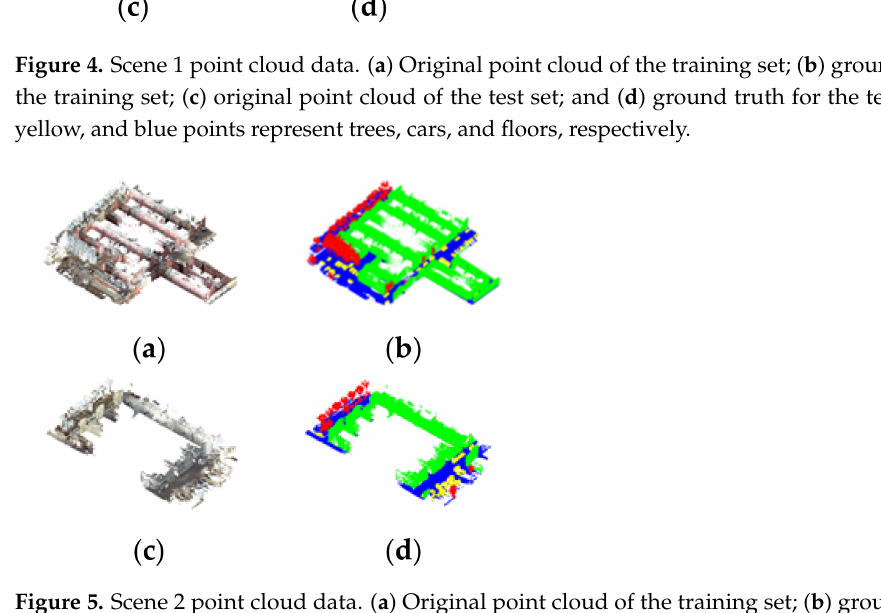
Figure 5. Scene 2 point cloud data. ( a ) Original point cloud of the training set; ( b ) ground truth of the training set; ( c ) original point cloud of the test set; and ( d ) ground truth of the test set. Red, green, yellow, and blue points represent trees, cars, buildings, and floors, respectively.